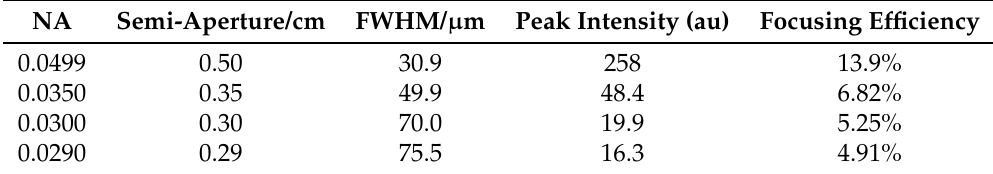
Table 1. Simulated data for the 3000 nm devices with focal length 10 cm.